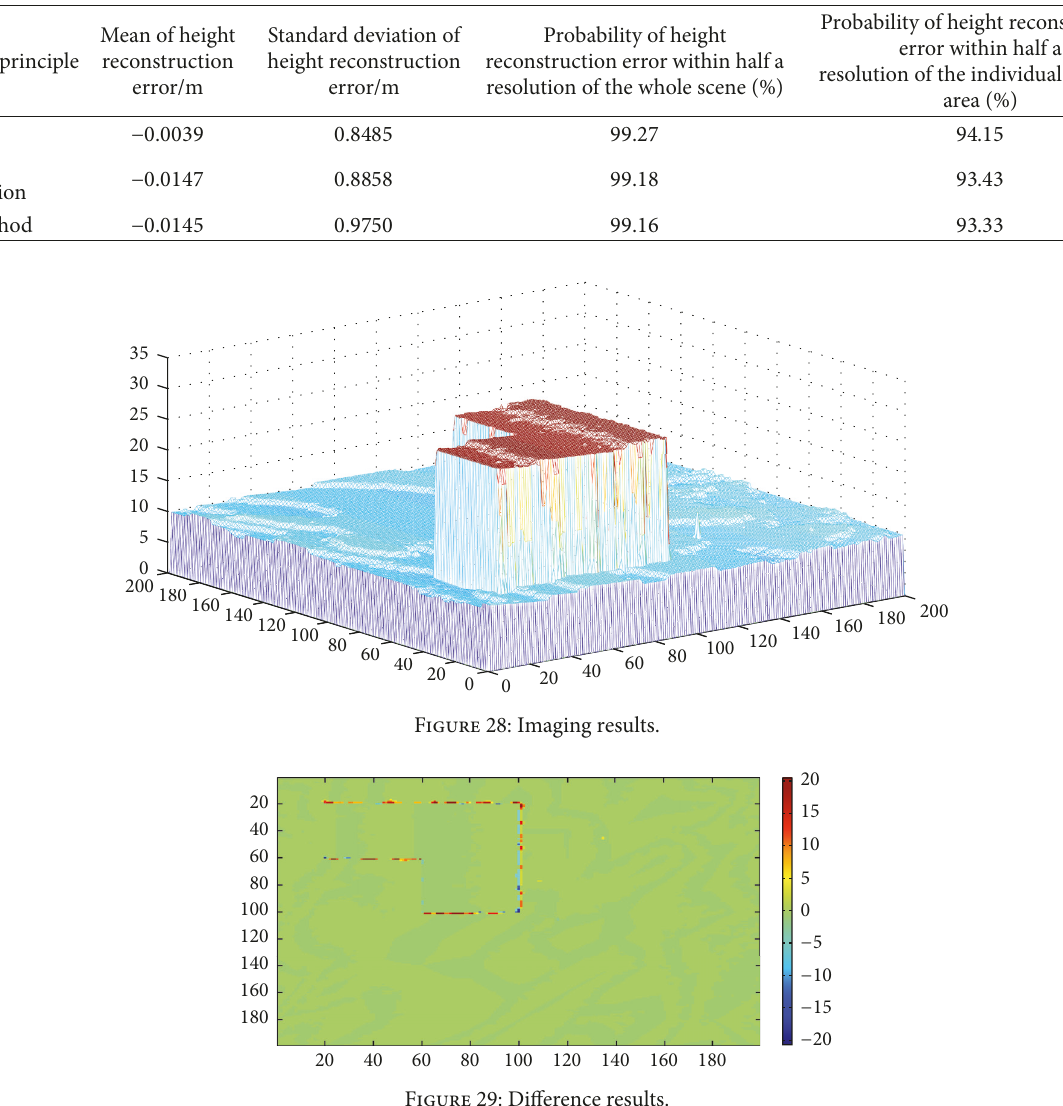
Figure 29: Difference